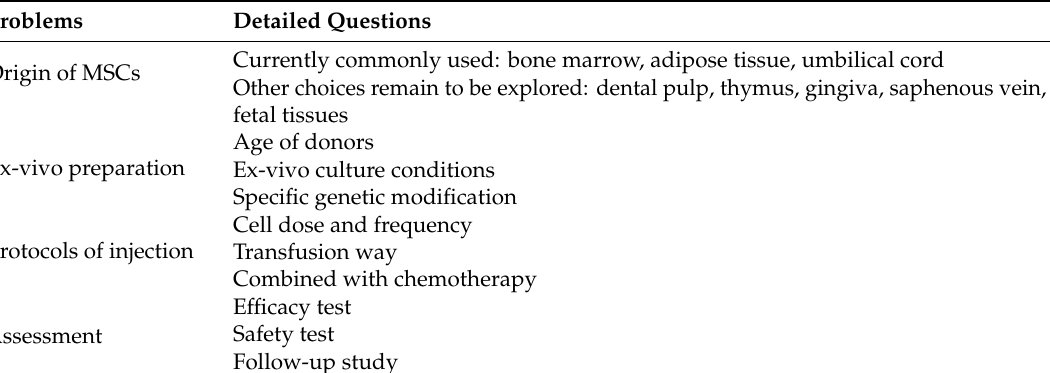
Table 2. The challenges in clinical application of MSC